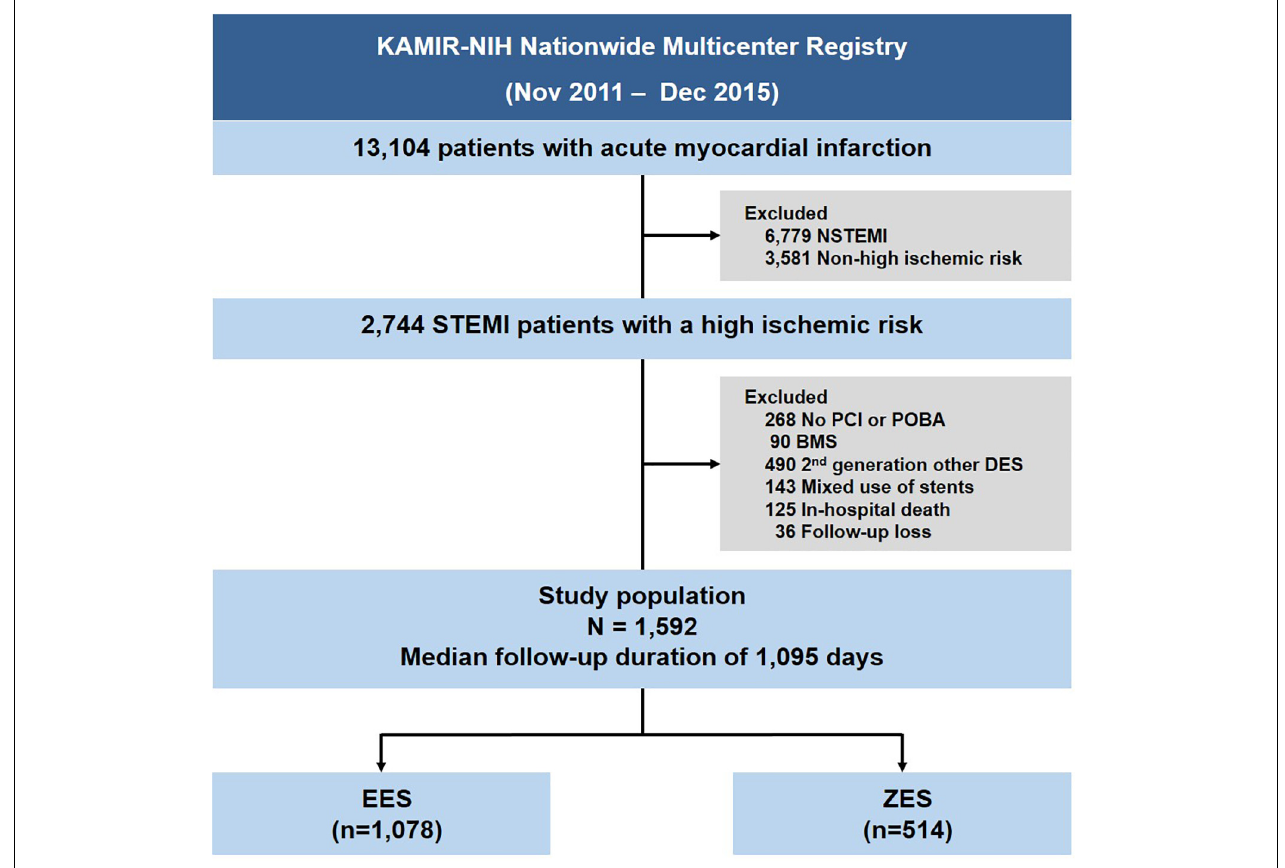
FIGURE 1 | Study flow chart. STEMI, ST-elevation myocardial infarction; NSTEMI, non-ST-segment elevation myocardial infarction; PCI, percutaneous coronary intervention; POBA, plain old balloon angioplasty; BMS, bare-metal stent; DES, drug-eluting stent; EES, everolimus-eluting stent; ZES, zotarolimus-eluting stent.